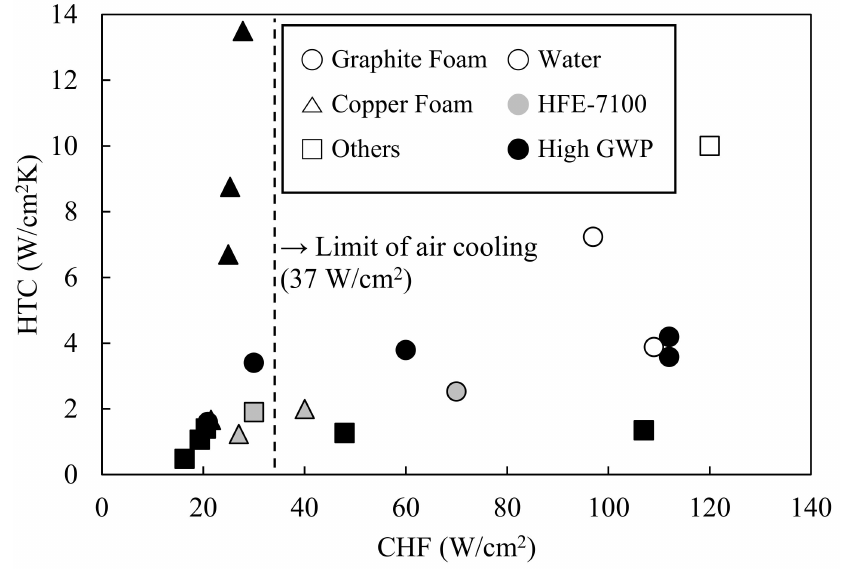
Figure 8. Summary of the